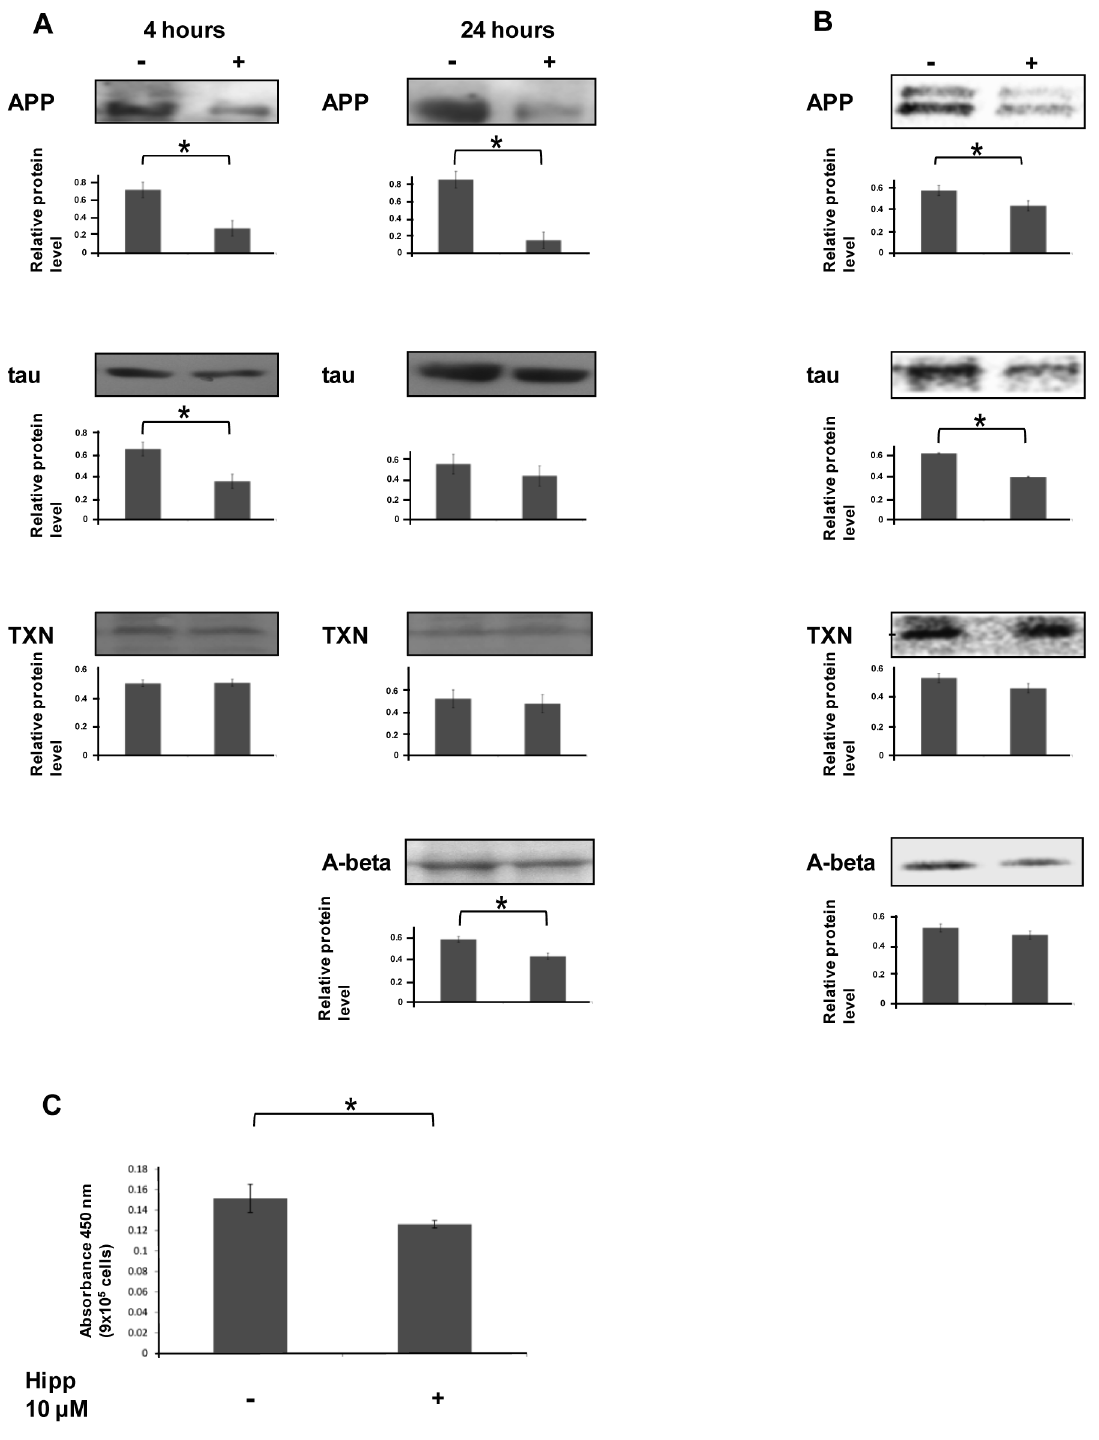
Figure 2. Expression of proteins associated with AD is altered by eIF4A inhibition. A Western analysis was performed on lysates from SH- SY5Y cells treated with 10 m M hippuristanol ( + ) or DMSO control ( 2 ) for 4 or 24 hours with antibodies specific to APP, TAU and TXN (bands of around 70 kDa, 60 kDa and 12–14 kDa respectively). The 70 kDa band was detected by the APP specific antibody representing a cleavage product specific to K + isoforms [53]. Secreted A-beta was measured by western analysis of cell culture media. The 56 kDa product is interpreted as an aggregate of A- beta, as has previously been reported for western analysis of brain tissue [51]. Protein levels were normalized to actin, and mean relative proportions of protein with standard errors are indicated beneath each gel image. Significant differences (p # 0.05 by t-test) are indicated by asterisks. B . Immunoprecipitation following 35 S-methionine labeling demonstrates a reduction in novel synthesis of APP, TAU but not TXN when SH-SY5Y cells are treated with 10 m M hippuristanol. Secreted A-beta levels are also reduced, as determined by immunoprecipitation from cell culture medium. Mean relative proportions of protein with standard errors are indicated beneath each gel image. Significant differences (p # 0.05 by t-test) are indicated by asterisks. C . Secreted A-beta levels in the medium of 9 6 10 5 SH-SY5Y cells were assayed by ELISA 24 hours following treatment with 10 m M